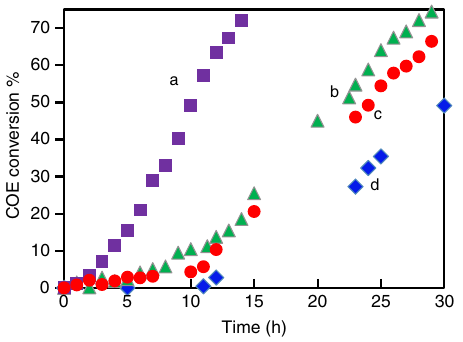
Figure 1 | Time course of cyclooctene conversion. COE conversion using 80mg Au/SiO 2 -A (a, square), 6mg AuCl (b, triangle), 7mg AuCl 3 (c, circle), or no Au (d, diamond). Reaction conditions: 10ml COE, 1ml decane, O 2 bubbling rate 30mlmin (cid:2) 1 , 100 (cid:2) C. For experiments with Au/SiO 2 or when no Au was present, COE was stabilizer free but, for experiments with AuCl and AuCl 3, COE contained 100–200p.p.m. Irganox 1,076 stabilizer. Conversion is defined based on initial COE present. NATURE COMMUNICATIONS|8:14881|DOI: